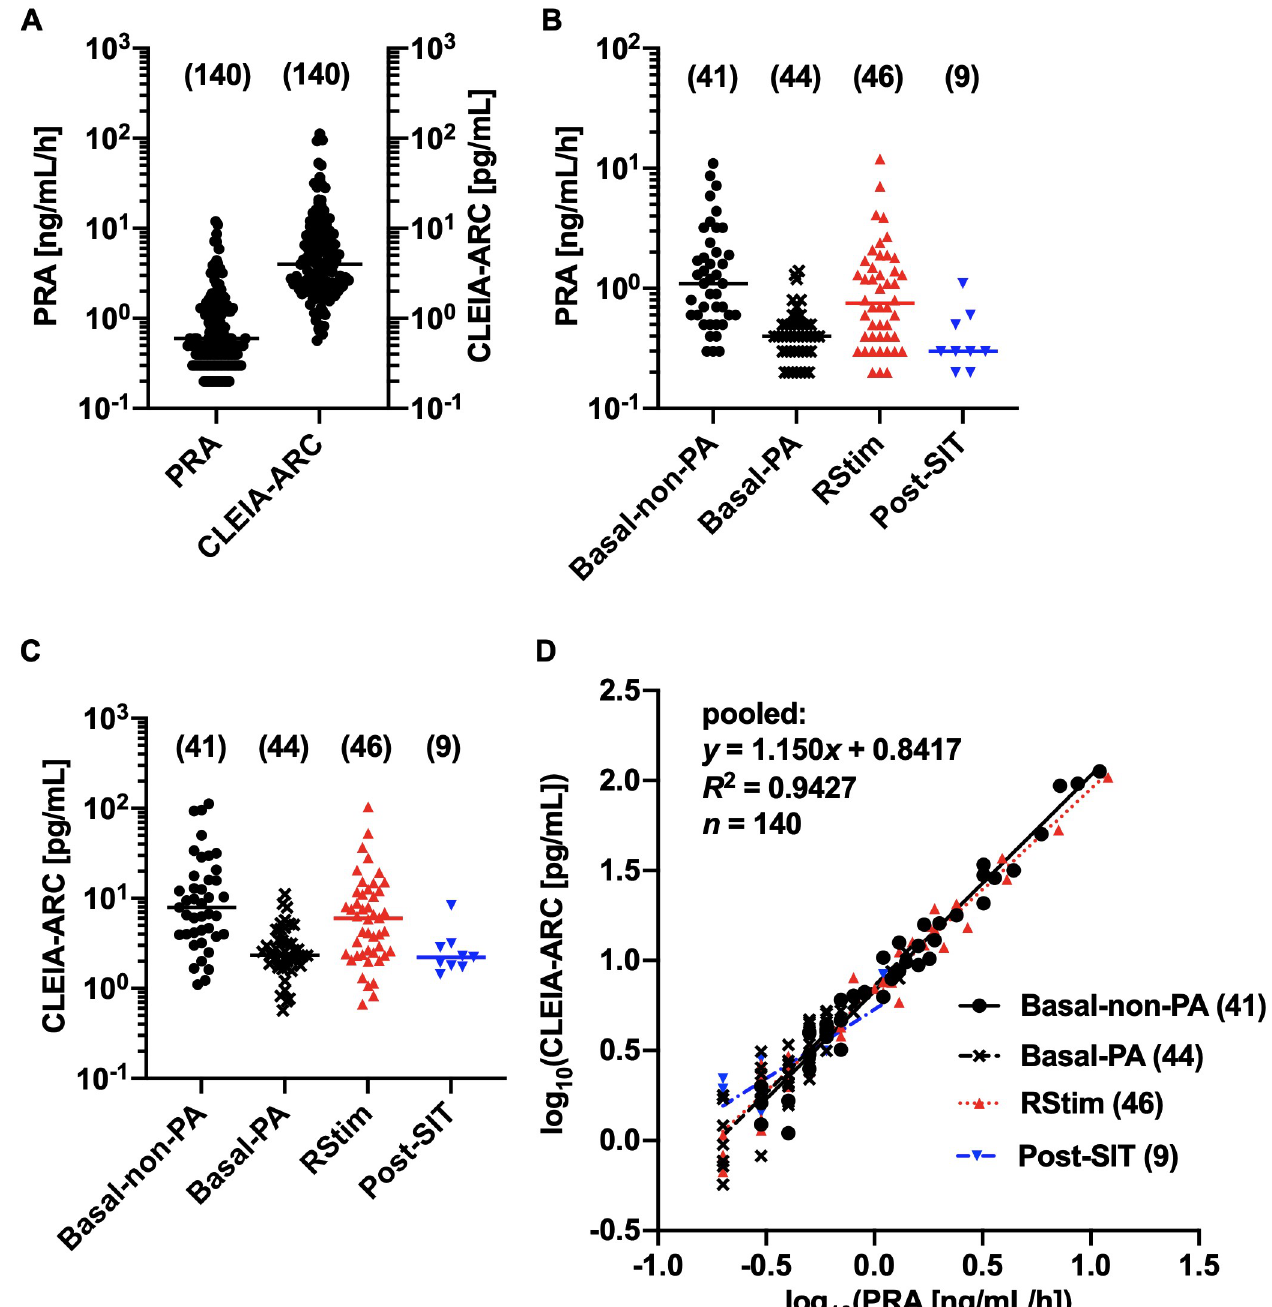
Fig 2. Distributions of PRA and CLEIA-ARC values and relations between them. (A) The distributions of PRA and CLEIA-ARC values of all eligible samples. (B) The distributions of PRA values of the Basal-non-PA, Basal-PA, renin stimulation test (RStim), and Post-SIT groups. (C) The distributions of CLEIA-ARC values of the above four groups. (D) The linear regression analysis between the log-transformed values of CLEIA-ARC and PRA. The equation of linear regression line by the pooled analysis is shown. The numbers of analyzed samples are shown in parentheses. Medians are indicated by horizontal bars in panels